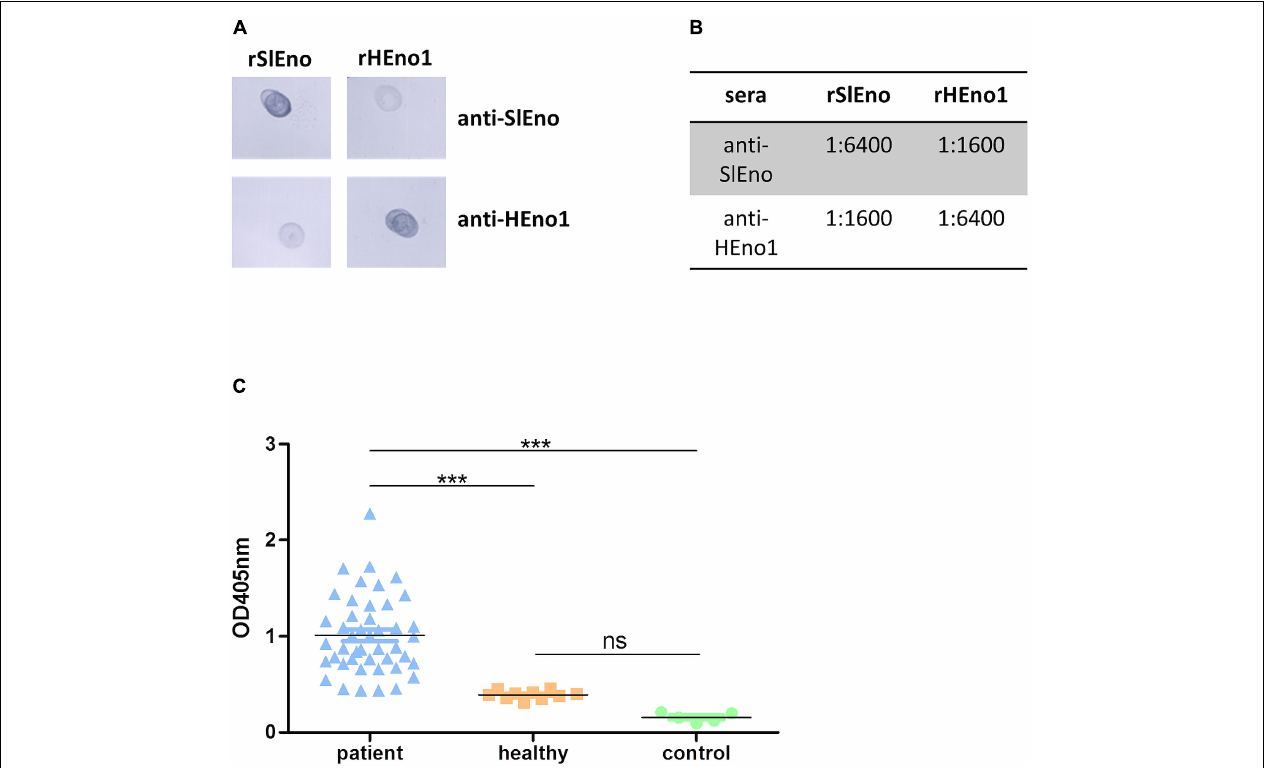
FIGURE 3 | Evaluation of anti- S. lugdunensis enolase (SlEno) or anti-human enolase (HEno) antibody cross reactions against recombinant enolase of S. lugdunensis (rSlEno), or recombinant HEno (rHEno), and determination of cross reactions to rSlEno by incubation with sera drawn from patients with Staphylococcus aureus infections and control sera. (A) Of each recombinant enolase [rSlEno– S. lugdunensis ; recombinant human Eno1 protein (rHENO1)–human enolase 1], 5 µ g was spotted on nitrocellulose membrane, blocked, and incubated with 1:10,000 diluted polyclonal anti-SlEno or anti-HEno1 rabbit antibodies. (B) Determination of cross reactions between rSlEno and rHEno1 with anti-HEno1 or anti-SlEno rabbit antibodies using an ELISA approach. Of purified rSlEno or rHEno1, 0.2 µ g was coated on microtiter plates and incubated with different concentrations of anti-SlEno or anti-hEno1 rabbit antibodies. The dilution factor endpoint was 1:6,400. After incubation with anti-rabbit antibodies, plates were washed, incubated with alkaline phosphatase substrate, and monitored at 405 nm. (C) Cross reactions of antibodies against rSlEno were measured using an ELISA approach. To do that, rSlEno was immobilized on microtiter plates. Afterward, the microtiter plates were incubated with sera of patients suffering from infection with S. aureus (patient), sera of healthy blood donors (healthy), or PBS as control. Anti-enolase Abs were detected by AP-conjugated anti-human IgG Abs. Statistical analyses were performed using one-way ANOVA with Bonferroni multiple comparisons post-test (*** p < 0.001, ns, not